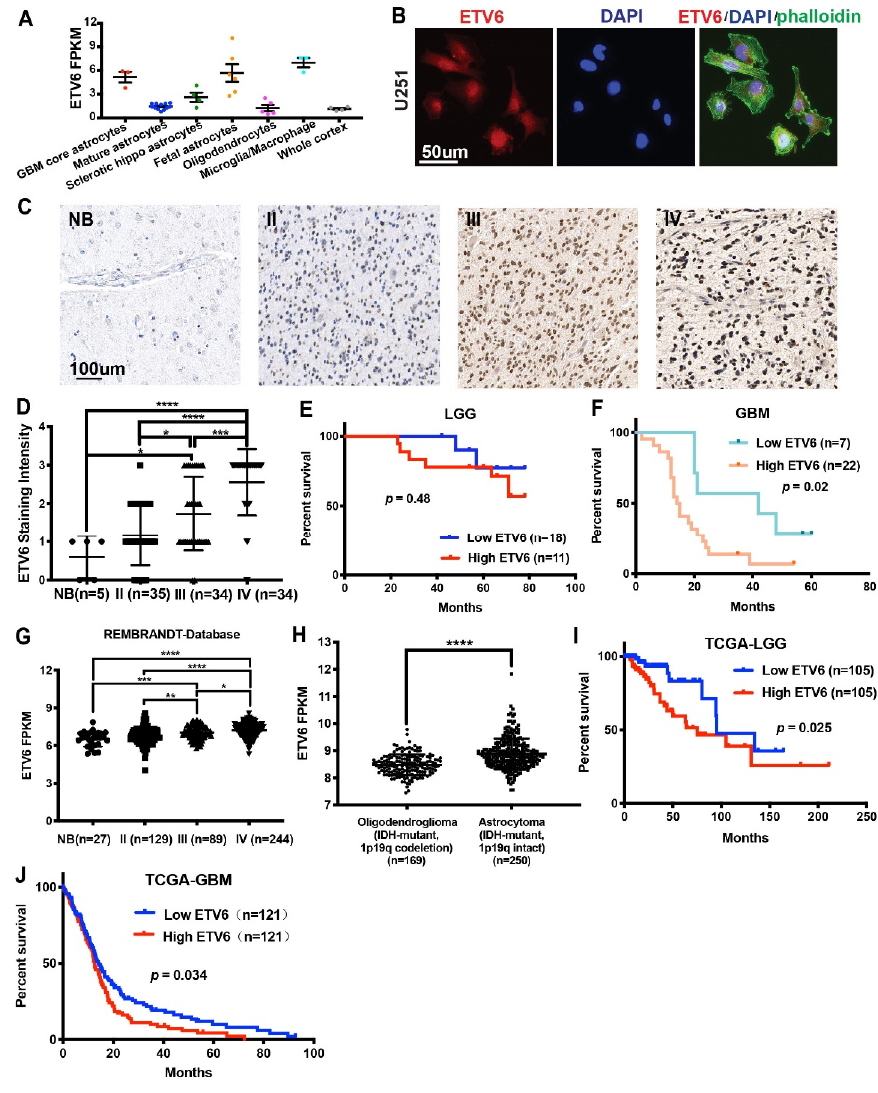
Figure 1. ETV6 expression was positively correlated with glioma grade and negatively correlated with patient prognosis. ( A ) ETV6 was one of the top upregulated genes expressed in both GBM astrocytes and fetal astrocytes compared to normal mature astrocytes as revealed by cell-type-specific RNA-seq [1]. ( B ) Immunofluorescence staining of ETV6 in U251 glioma cells showed its expression mainly in the nucleus. Scale bar, 50 µ m. ( C ) Representative images of ETV6 staining of normal brains, grade II, III, and IV gliomas from tissue microarrays were shown. Scale bar, 100 µ m. ( D ) The staining intensity of ETV6 was scored as 0–3 on normal brain and grade II–IV glioma ( n = 5, 35, 34, 34, respectively). ETV6 staining was positively correlated with the grade of glioma. ( E ) ETV6 expression was not significantly correlated with the survival in IDH-mutant LGG ( n = 18 for low ETV6 vs. n = 11 for high ETV6 group, p = 0.48). ( F ) ETV6 expression was negatively correlated with patient outcome in IDH-wildtype GBM ( n = 7 for low ETV6 vs. n = 22 for high ETV6 group, p = 0.02). ( G ) ETV6 mRNA expression was positively correlated with the WHO grade of glioma in the REMBRANDT database; n = 27, 129, 89, 244 for normal brain and grade II–IV glioma, respectively. ( H ) ETV6 mRNA expression was significantly higher in astrocytoma (IDH-mutant and 1p19q intact) than oligodendroglioma (IDH-mutant and 1p19q codeletion) from TCGA; n = 250 and n = 169 for astrocytoma and oligodendroglioma, respectively. ( I , J ) High ETV6 expression was a dismal prognostic factor in IDH-mutant LGG ( n = 105 for low and high ETV6 groups, respectively, p = 0.025) and IDH-wildtype GBM ( n = 121 for low and high ETV6 groups, respectively, p = 0.034) from TCGA (*, p < 0.05; **, p < 0.01; ***, p < 0.001; ****, p <